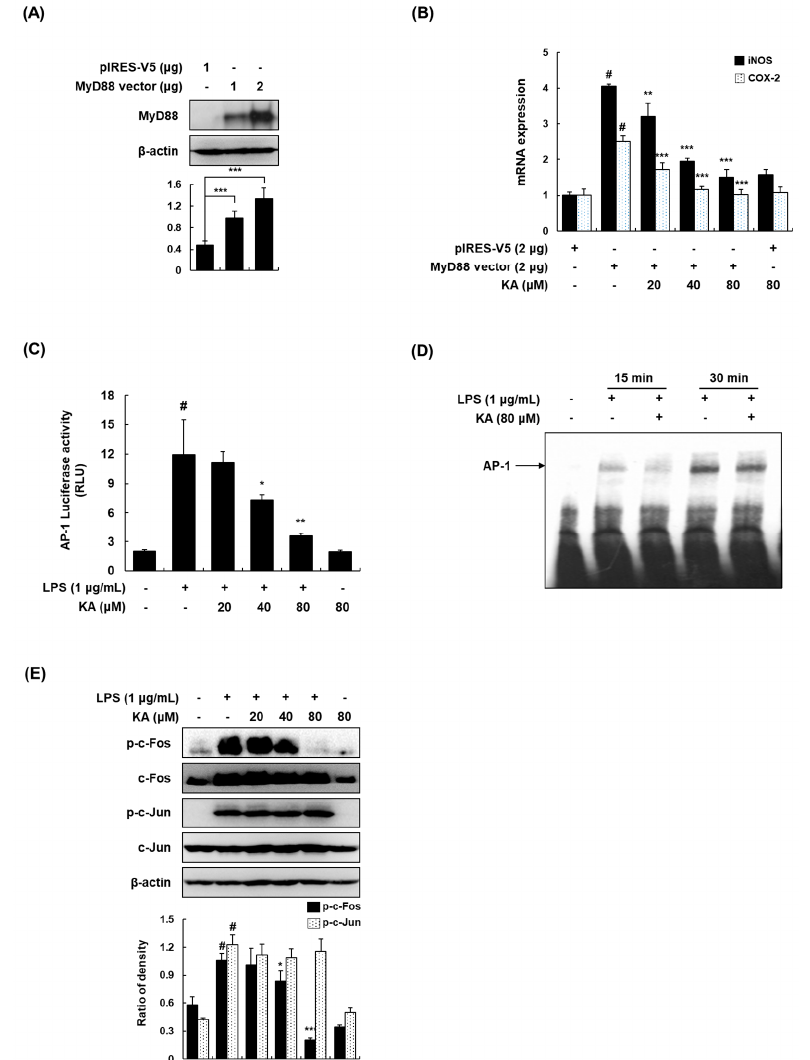
Figure 3. Effects of KA on the activator protein-1 (AP-1) signaling pathway in LPS-stimulated